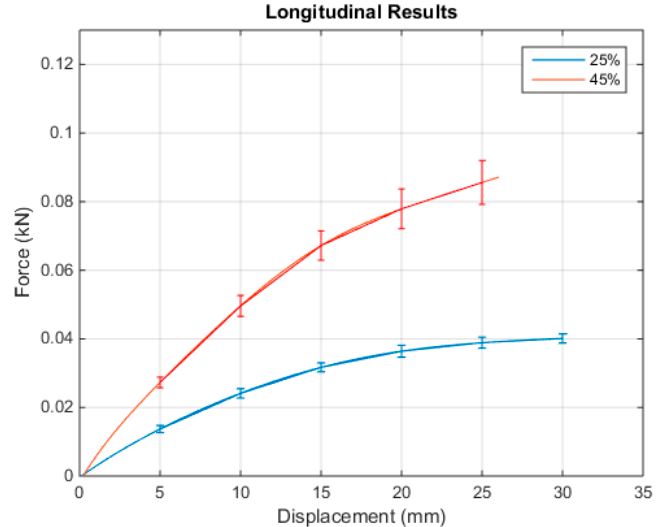
Figure A3. Longitudinal Results with Standard Deviation Error Bars.